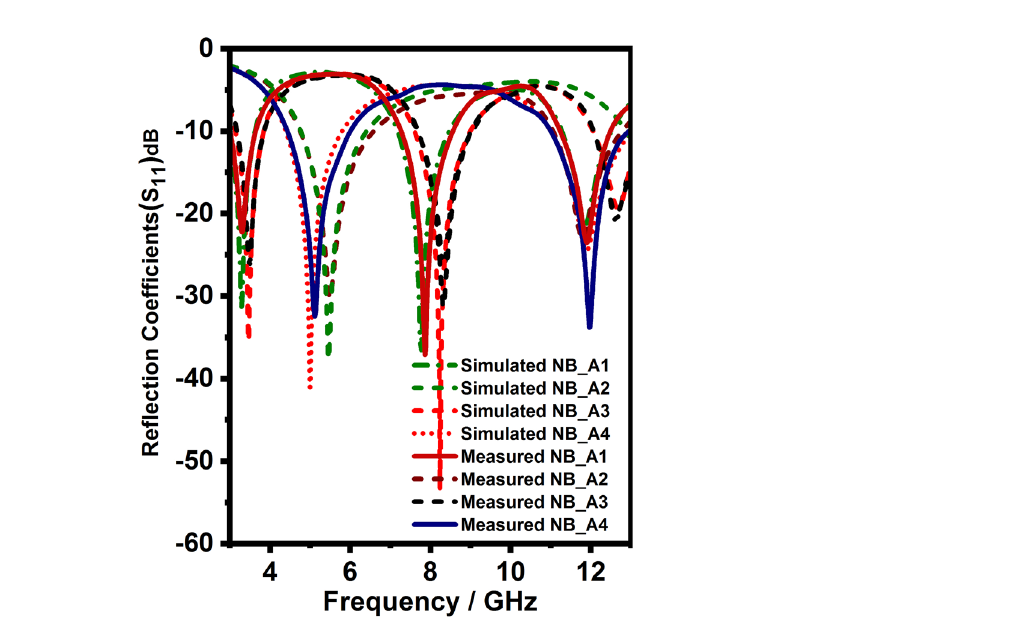
Figure 14. Reflection coefficients (Simulated and measured) NB